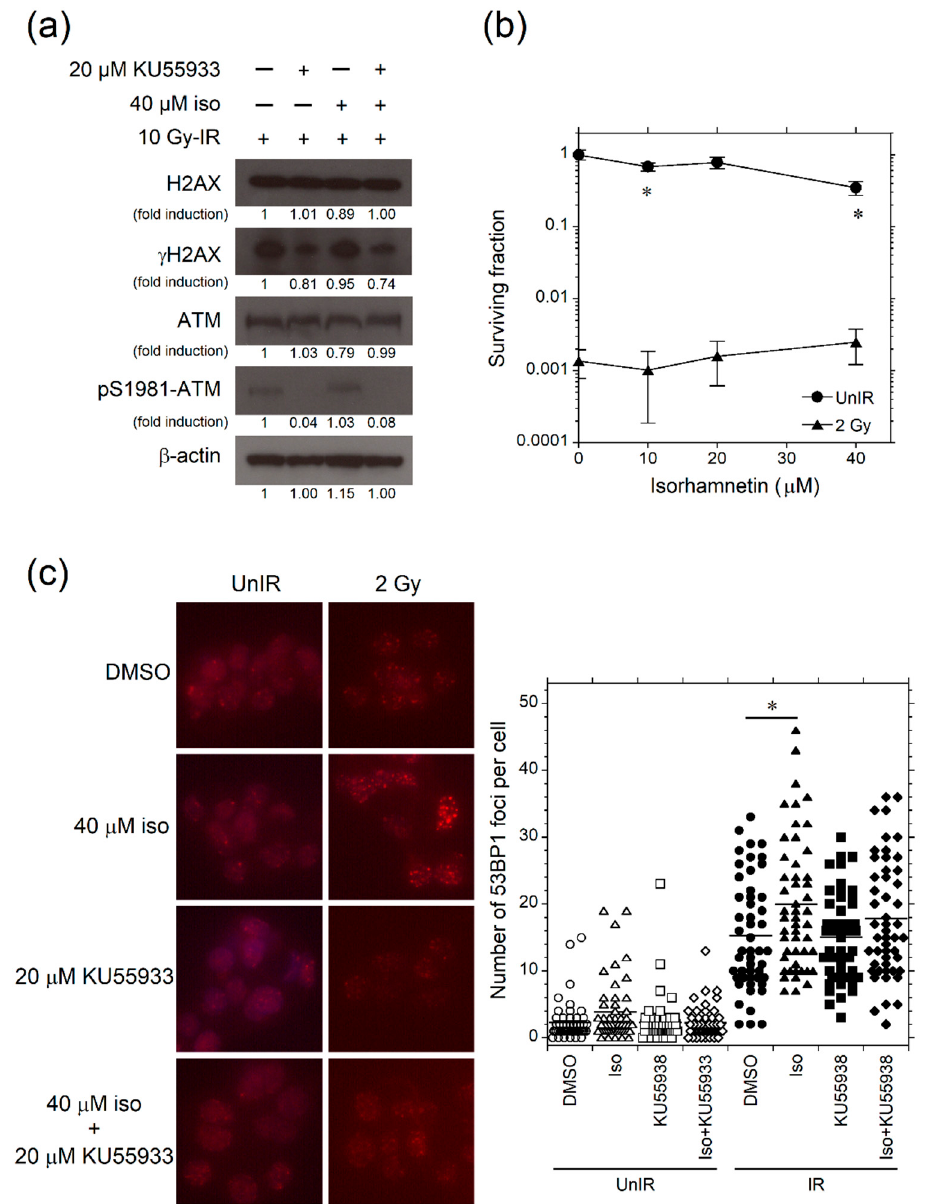
Figure 5. Isorhamnetin exhibits radioprotective effect through the ATM-dependent promotion of 53BP1 recruitment. ( a ) Isorhamnetin could not promote ATM and H2AX phosphorylation in irradiated MOLT-4 cells at the presence of ATM inhibitor (KU55933). Data were obtained 0.5 h after 10 Gy irradiation. The original value of each signal intensity ratio was determined using the signal intensity obtained from cells 0.5 h after 10 Gy irradiation (1.5 h after DMSO treatment) as a control (lane 1). The band intensity ratio of each sample was then normalized by the band intensity ratio of β -actin as an internal control. ( b ) Isorhamnetin could not enhance colony forming activity in the presence of the ATM inhibitor ( n = 5). ( c ) 53BP1 foci in Hep G2 cells 4 h after 2 Gy irradiation. The foci and DNA were stained with 53BP1-specific antibody and DAPI, respectively. The number of 53BP1 foci per nucleus was quantified ( n = 50). Magnification, 40 × . An asterisk indicates a significant difference (* p < 0.05) between groups. DMSO dimethyl sulfoxide, Iso isorhamnetin, IR irradiated, UnIR unirradiated.